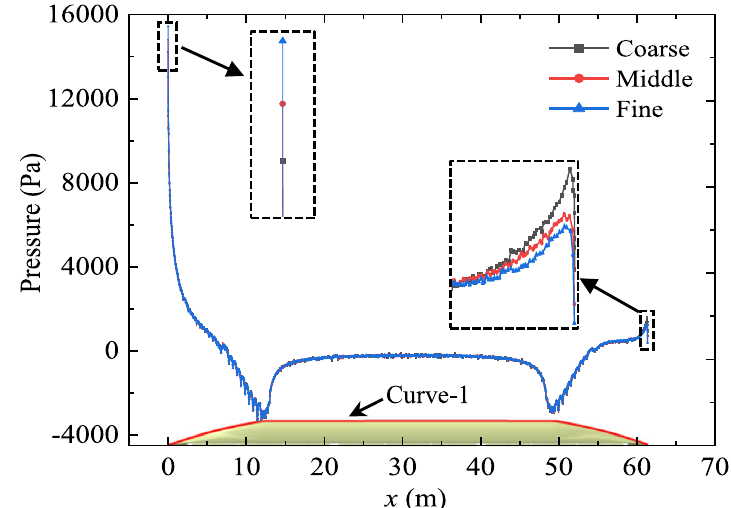
Fig. 5 Comparison of pressure under different mesh